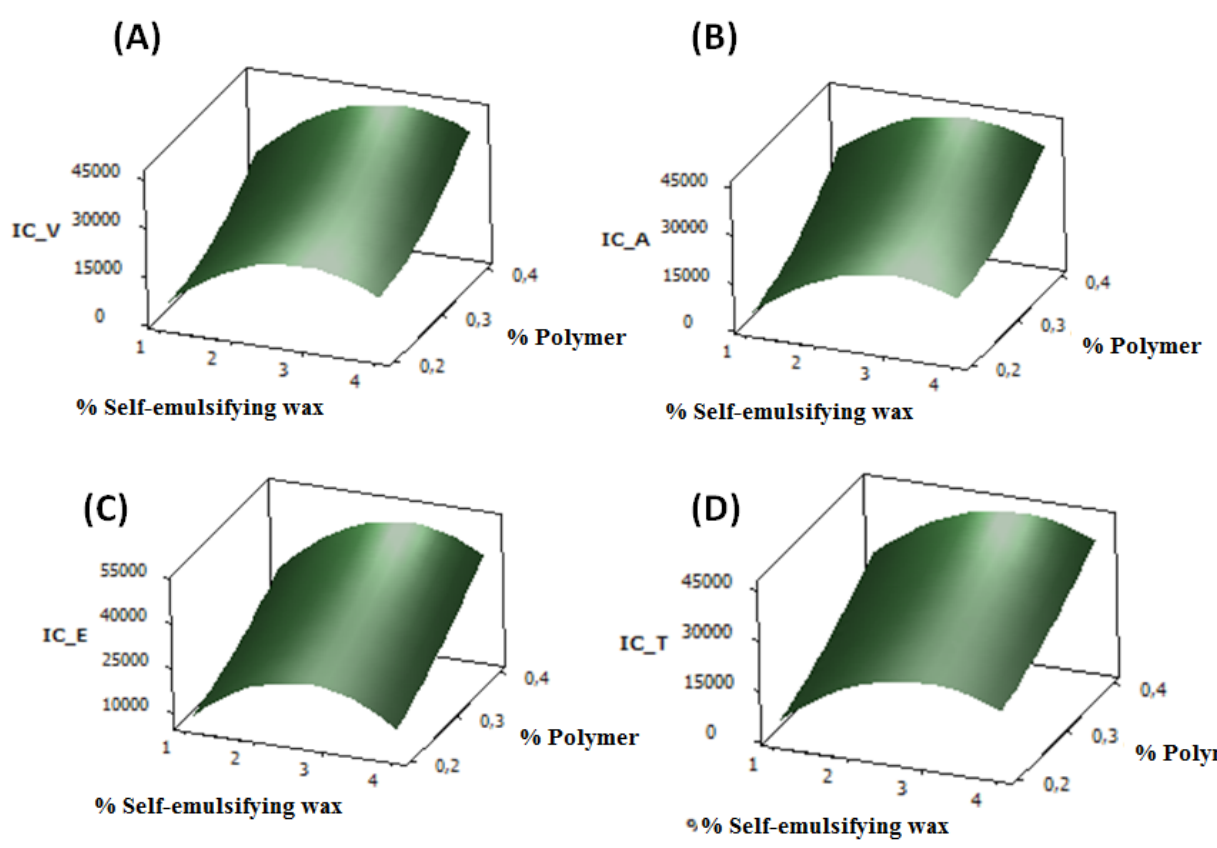
FIGURE 1 - Response surfaces for consistency index (CI) as a function of the factors: % of self-emulsifying wax and % hydrophilic polymer for the formulations: vehicle (A) containing 0.5% retinyl palmitate (B), 5% tocopheryl acetate (C) and 0.1% tocoretinate